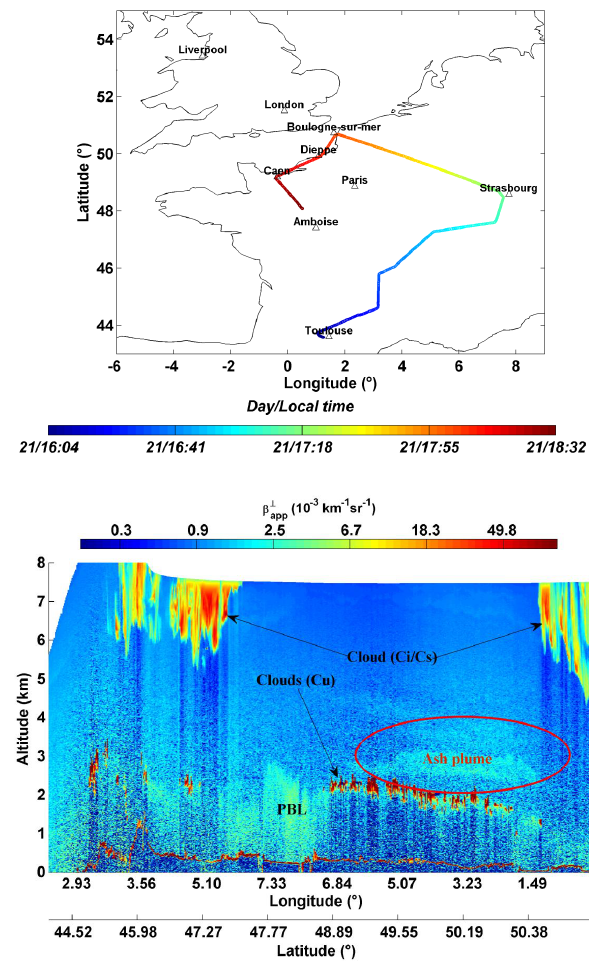
Figure 3: Flight for 21 April 2010. Top panel shows the flight plane above France where the 582 Fig. 3. Flight for 21 April 2010. Top panel shows the flight plane main crossed cities are given. Bottom panel shows the temporal evolution of   app . The 583 above France where the main crossed cities are given. Bottom panel shallow ash plume is circled in red. 584 shows the temporal evolution of β ⊥ app . The shallow ash plume is circled in